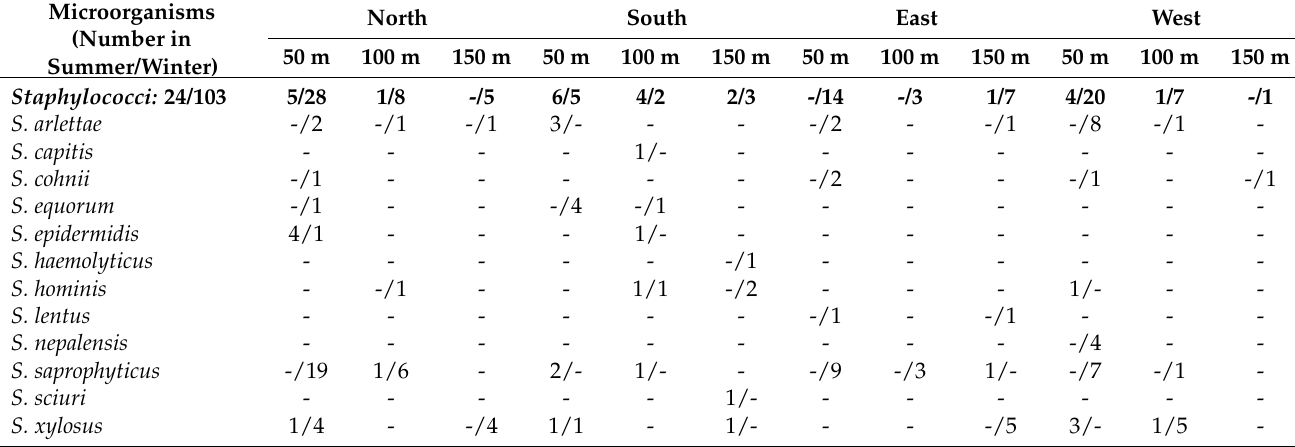
Table 3. Distribution of isolates identified in the outside air of the sampled broiler farm in relation to the point of sampling (distance from the farm and cardinal